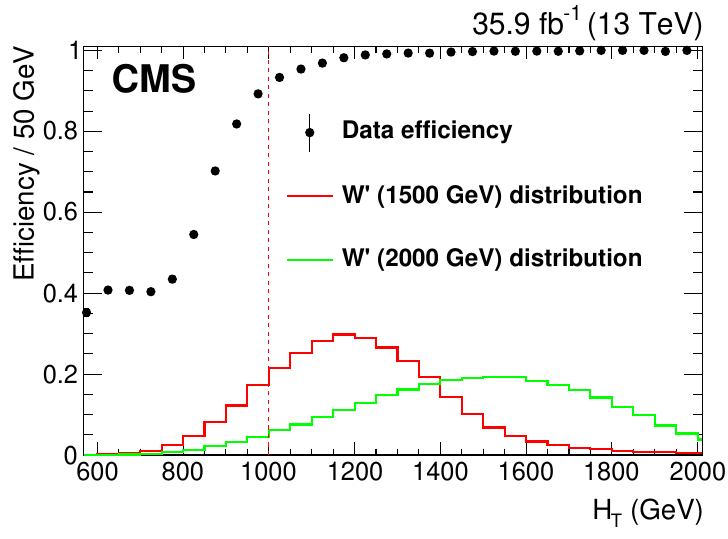
Figure 2 . Trigger e(cid:14)ciency as a function of H T . Events are required to have H T > 1 TeV as is indicated by the red dashed line. The H T distributions of two W comparison, normalized to unit